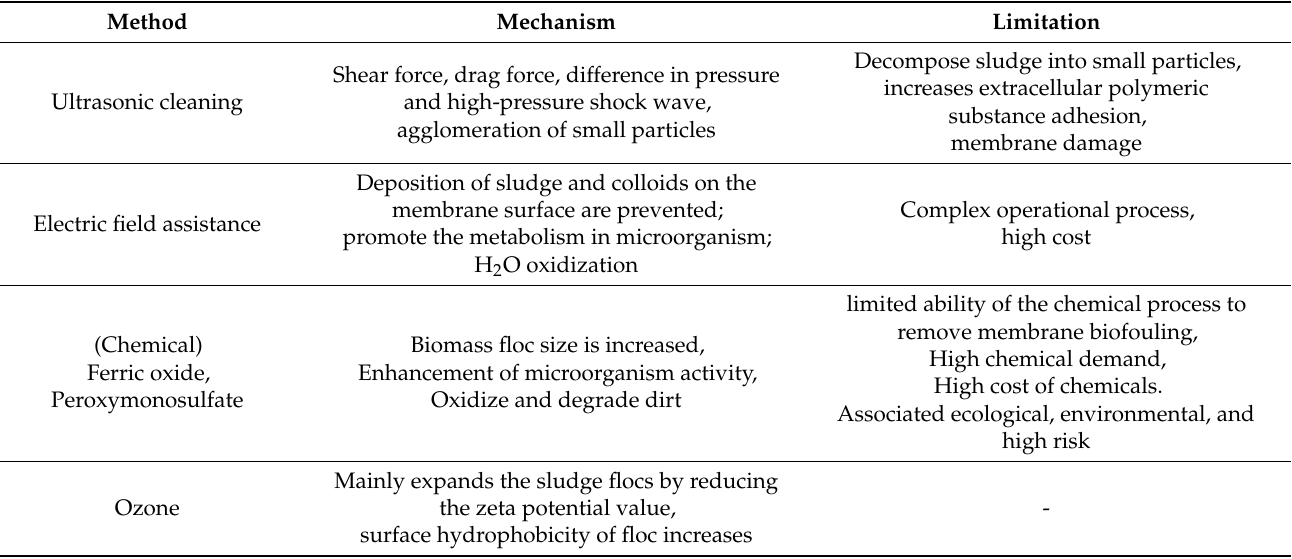
Table 5. Mechanism and limitation of selection physical and chemical biofouling control